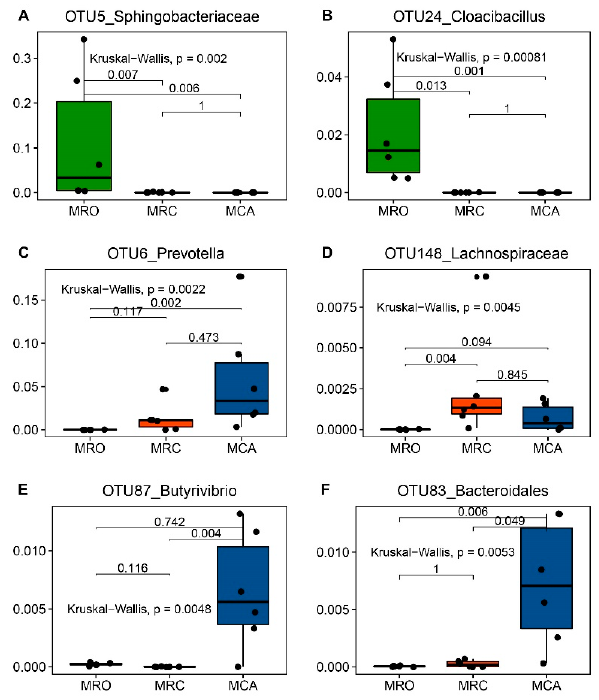
Figure 4. The highlight signature microbiota identified by AUCRF for differentiating MRO, MRC and MCA. The OTU5 (unclassified Sphingobacteriaceae ), OTU24 ( Cloacibacillus ) had high abundances in MRO group ( A-B ). OTU148 (unclassified Lachnospiraceae ) was higher in MRC and MCA ( D ). Other OTUs including OTU6 ( Prevotella ), OTU87 ( Butyrivibrio ) and OTU83 (unclassified Bacteroidales ) were significantly enriched in the MCA ( C, E and F ). All the OTUs abundances were tested using the Kruskal–Wallis test and a post-hoc Dunn Kruskal-Wallis multiple comparison with the Bonferroni method for p value correction being used. The black dots within each bar were values from individual animals, and the black lines within each bar represented the medians. MRO = milk replacer; MRC = milk replacer + concentrate; MCA = milk replacer + concentrate + alfalfa; AUCRF: Random Forest based on optimizing the area-under-the receiver operator characteristic curve (AUC).